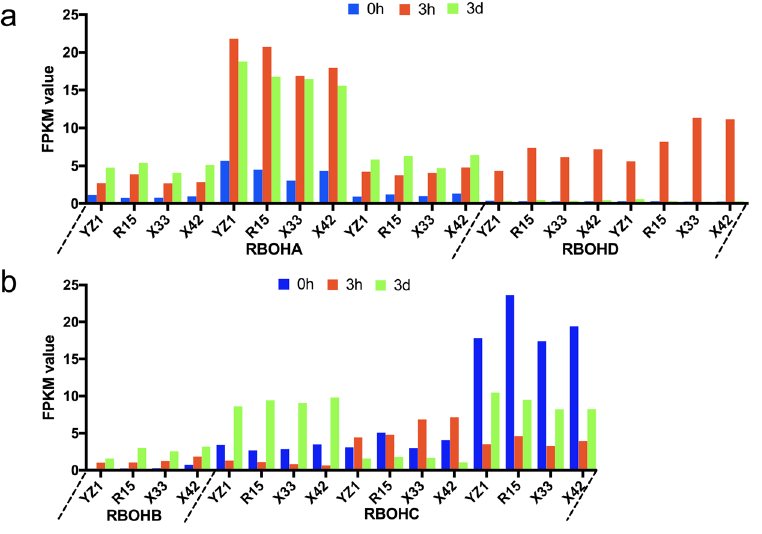
Figure 7. Expression of ROS